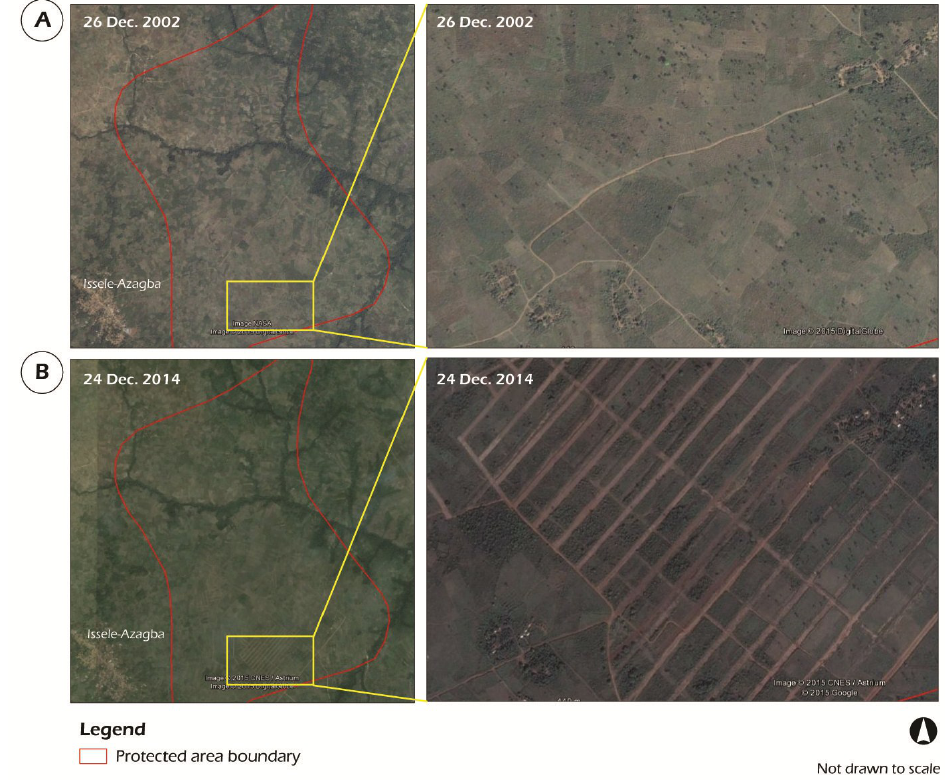
Figure 7. Map showing disturbed forest landscape within Niocha forest reserve (PA22) in Delta state for ( A ) 2002 and ( B ) 2014. (Source: “Niocha forest reserve, Delta state”. 6°17′08.77″ N, 6°37′27.60″ E. Google Earth . 5 July